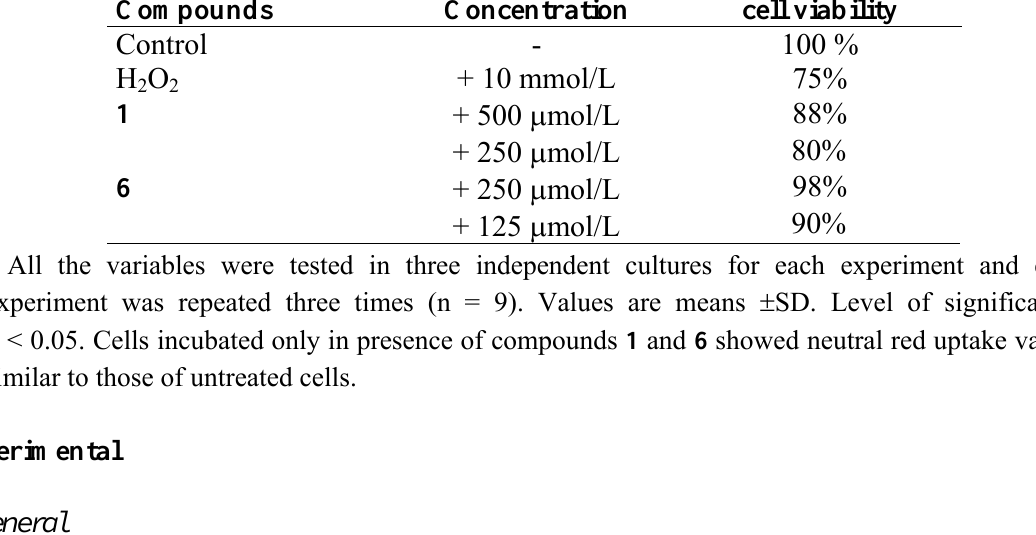
Table 6. Effect of compounds 1 and 6 on H